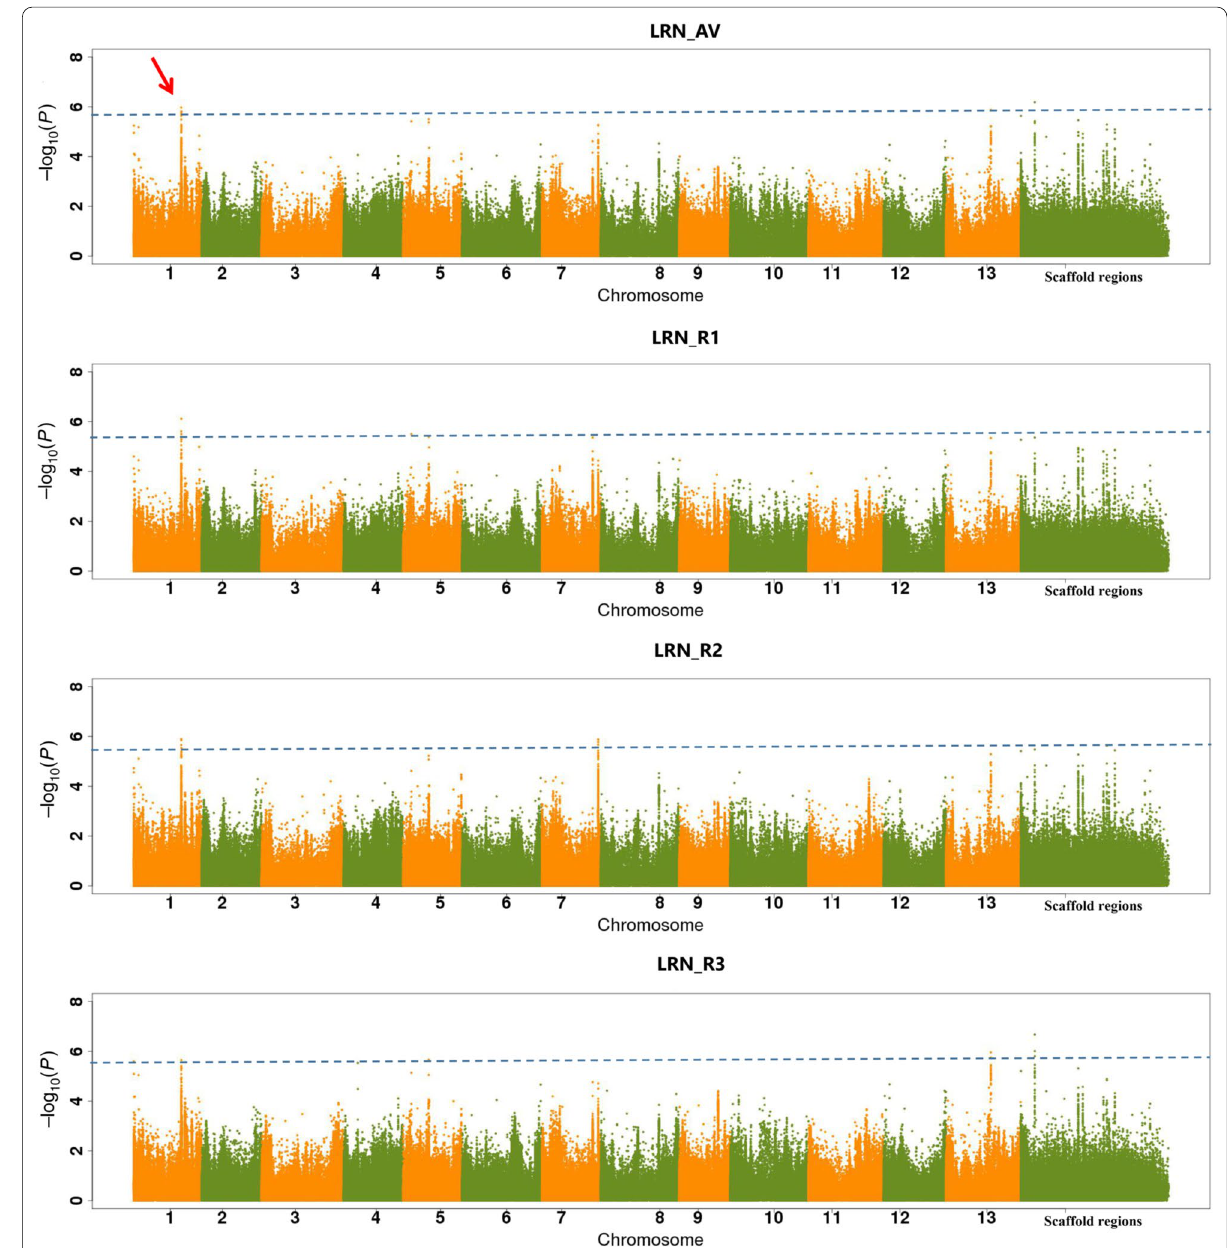
Fig. 3 Manhattan plots of lateral root number for 215 Gossypium arboreum accessions. AV represents the mean value of lateral root number, and R1, R2, R3 represent three replicates respectively. The significance threshold is shown by the blue dashed